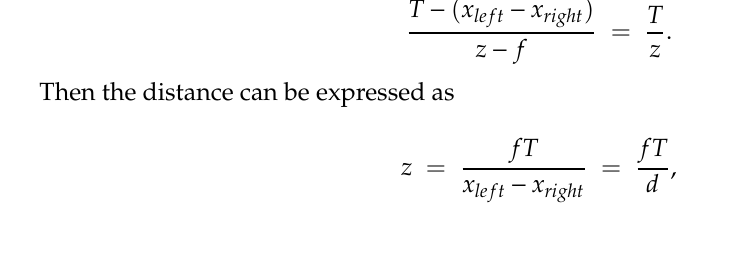
Figure 4. The parallel optical axis binocular system. (a) A simple schematic diagram of parallel optical axis binocular system. (b) The 2D plan of the schematic diagram.